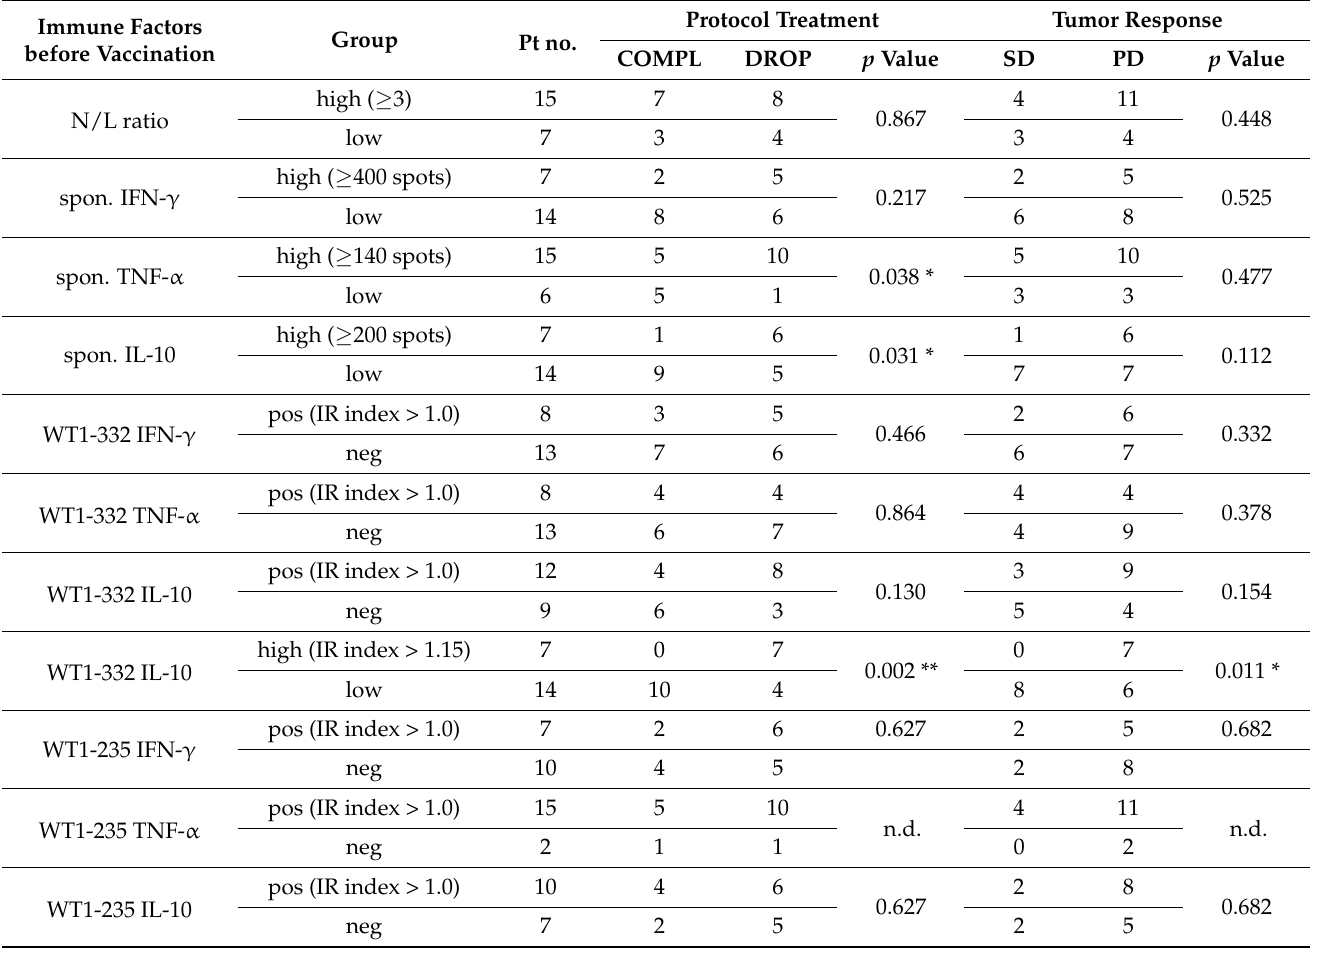
Table 4. Associations between immune factors before vaccination and clinical outcomes in patients with malignant